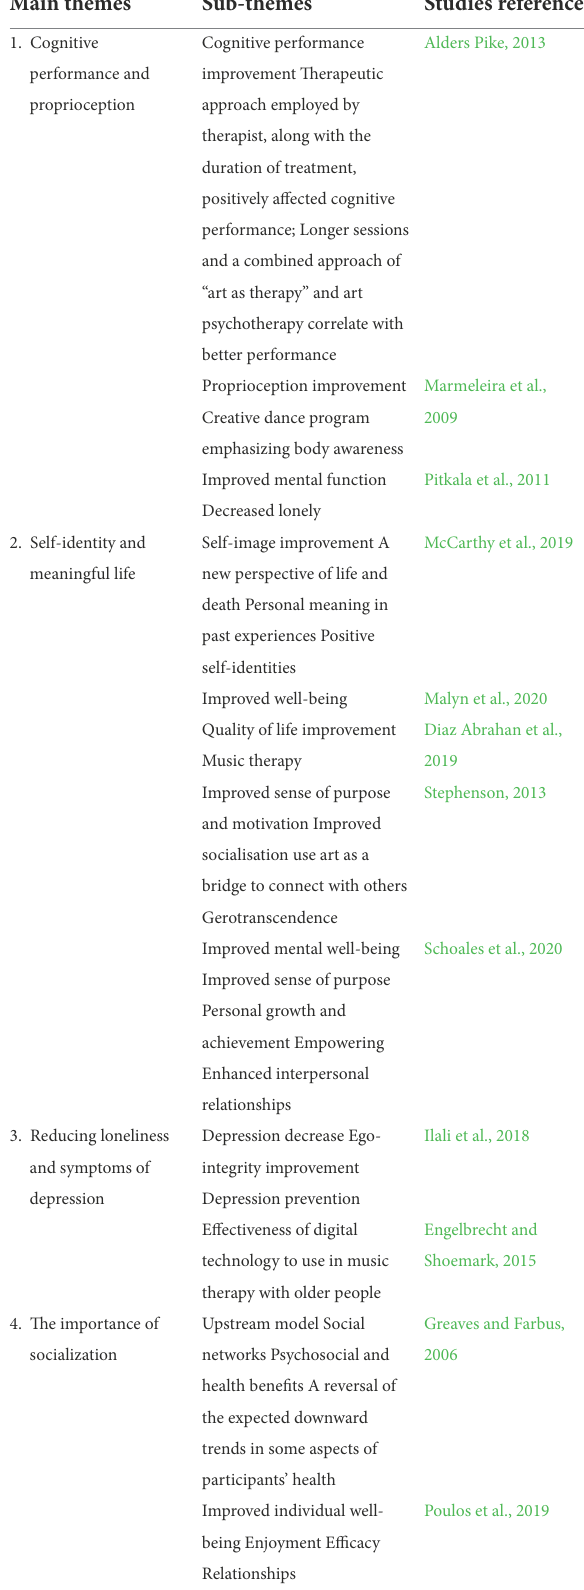
TABLE 3 Theme and sub-themes (when applicable) within selected